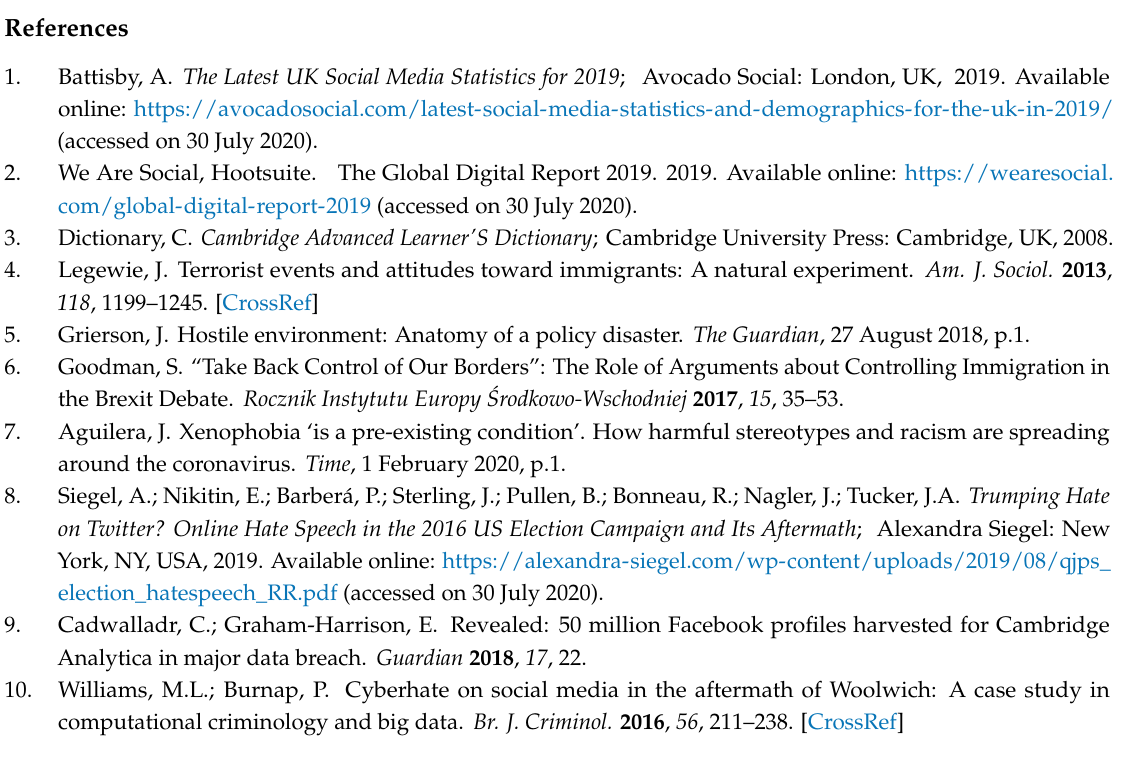
( f ) Top 10 cities/towns in “Non-Negative” class Figure A1. Top 10 hashtags, user mentions and cities/towns for “Negative” and “Non-Negative“